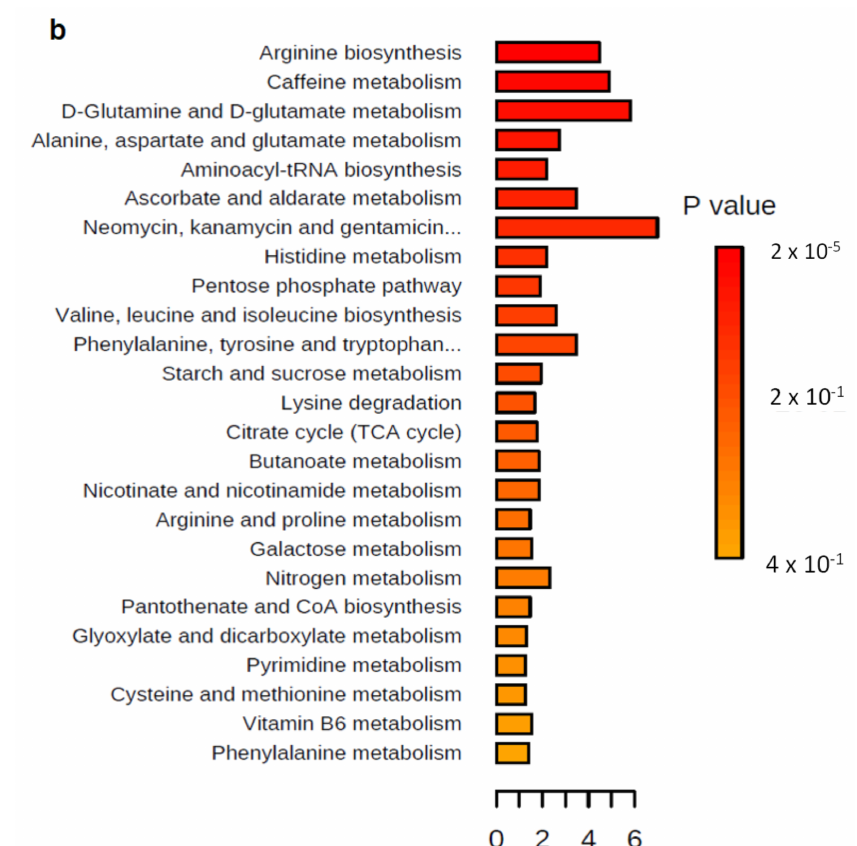
Figure 2. ( a ) Main chemical families represented in meconium and their numbers and percentages (number; name of the chemical family; percentage). ( b ) Enriched metabolic pathways identified through interrogation of the KEGG human metabolic pathways using Metaboanalyst 5.0 tools [28]. The enrichment ratio on the x-axis represents the number of metabolites assigned per metabolic pathway out of the total number of metabolites belonging to the pathway